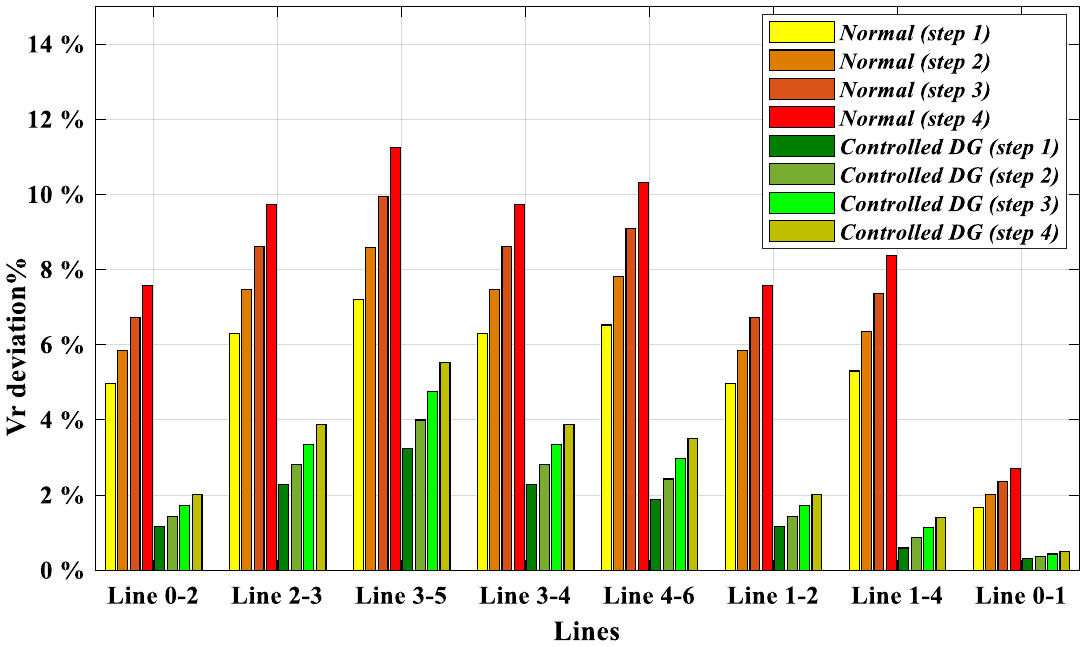
Figure 8. Receiving voltage deviation % for all transmission lines.